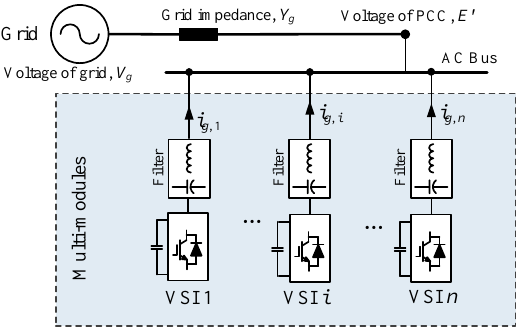
Figure 2. Simplified multi-parallel grid-connected VSI system considering the grid impedance.